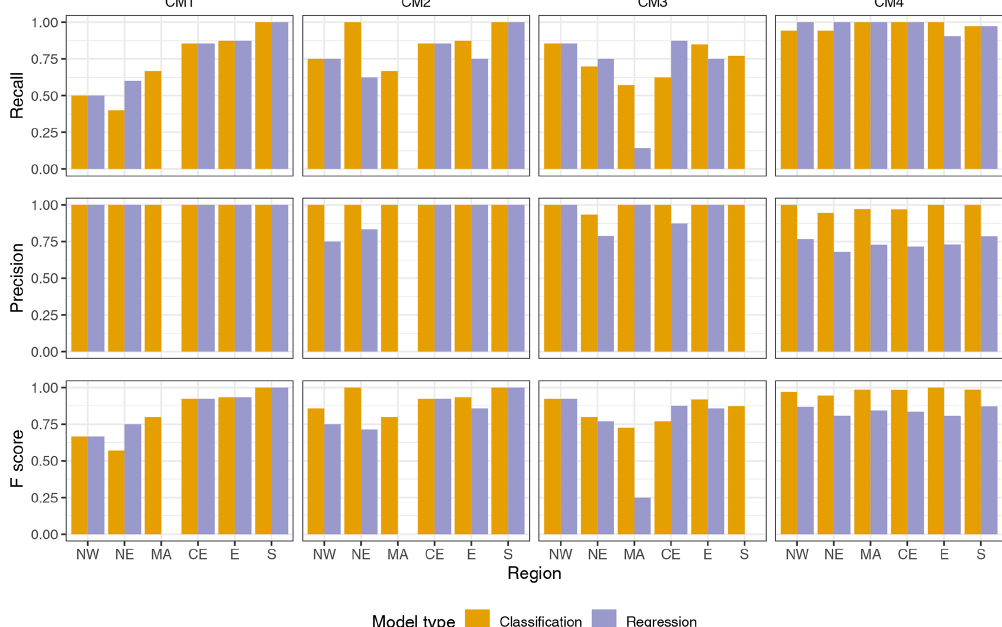
Figure 8. Performance metrics (recall, precision, and F score) of the random forest models when training and validating the models on 75% and 25% of the data. All counting methods are shown. The regression model test predictions were converted into binary outcomes using a threshold of